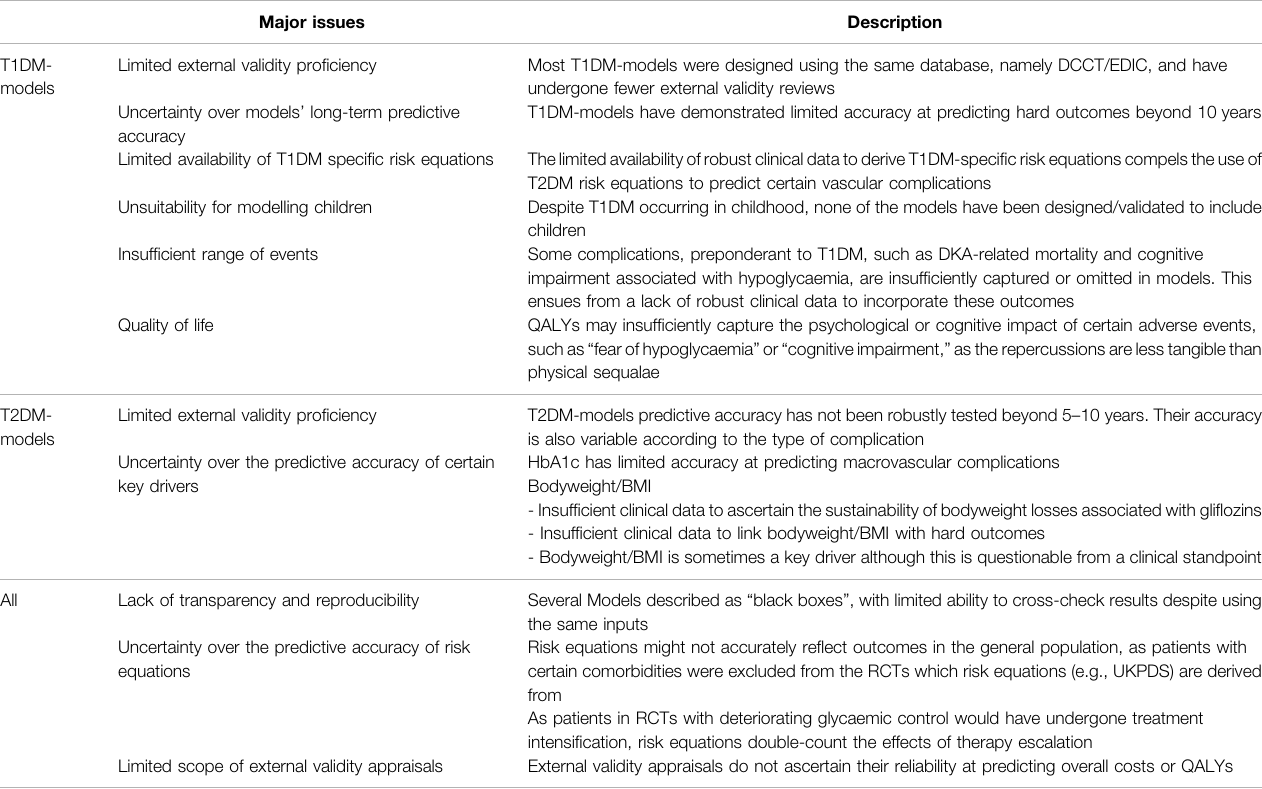
TABLE 3 | Summary of the major issues, speci fi c to T1DM and T2DM models or both, identi fi ed in the ERG and AG